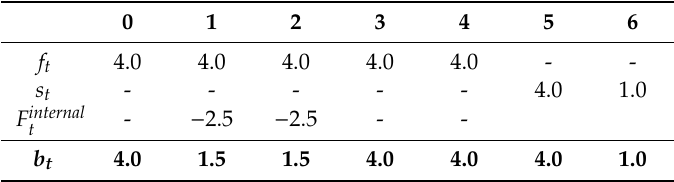
Table 1. Baseline calculation example for charging an electric vehicle